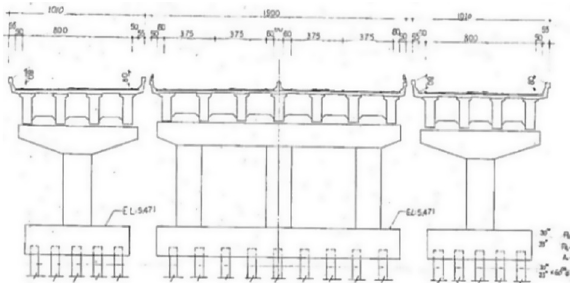
Figure 10: Cross-sectional view of the Shi-Bin